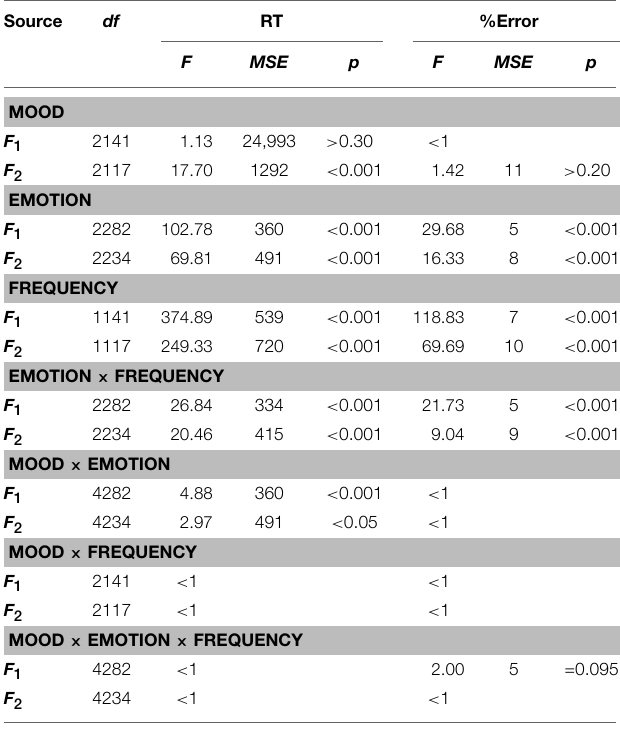
TABLE 5 | Main effects and interactions by participants ( F 1 ) and by items ( F 2 ) for RT and %Error measures.